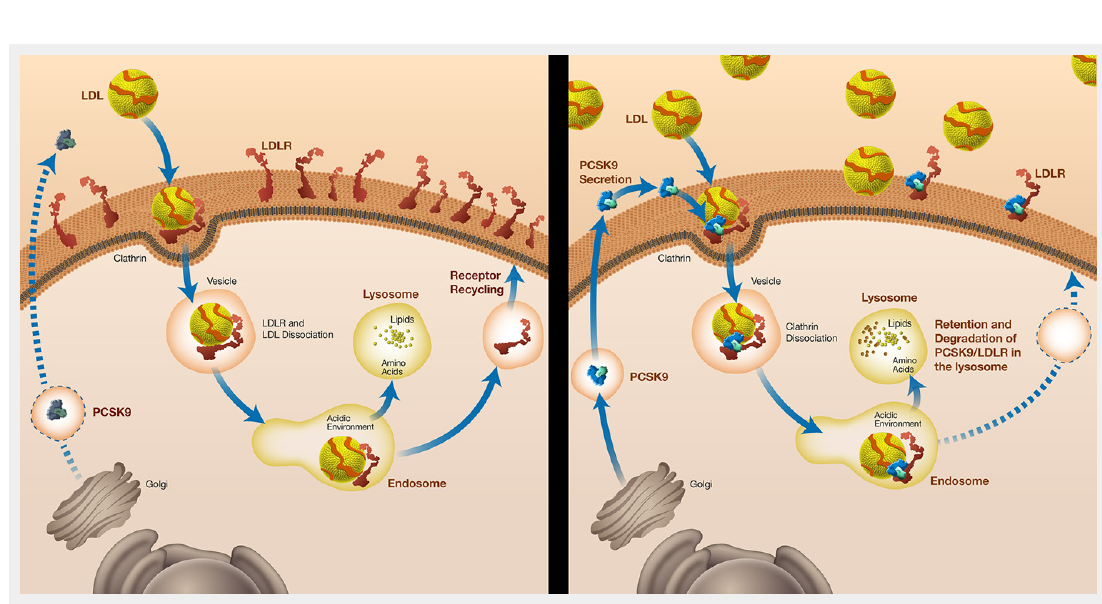
Figure 1 Description of the effect of proprotein convertase subtilisin/kexin type 9 (PCSK9) pathways on the low-density lipoprotein (LDL-C) levels. On the left, loss-of-function mutations or inhibition of PCSK9 result in an increased number of LDL receptors on the cell surface of hepatocytes, with lower levels of circulating LDL-C. On the right, gain-of-function of PCSK9 results in a decrease of LCL receptors on the cell surface of hepatocytes, with higher levels of circulating LDL-C. Reproduced with permission from Marais A.D., et al.